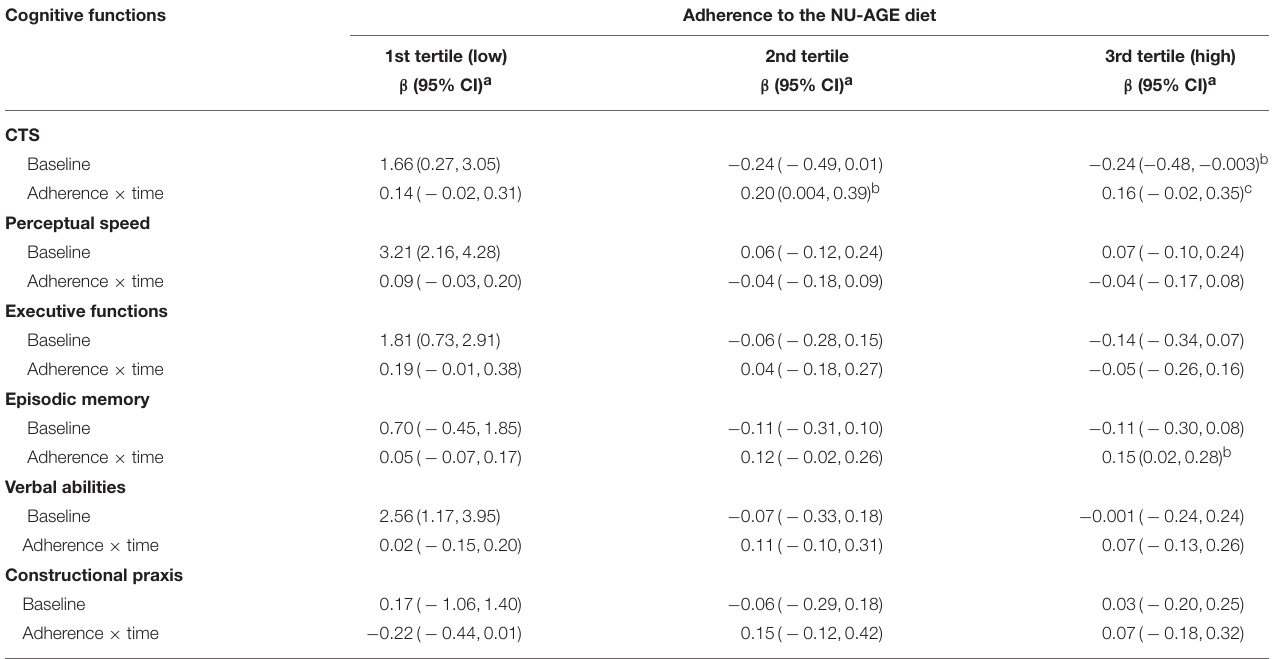
TABLE 4 | Estimated mean change in global and domain-specific cognitive functioning ( β -coefficients) and 95% confidence intervals by tertiles [1 (reference) to 3, corresponding to low to high adherence] to the NU-AGE diet over 1-year of follow-up, among the intervention group ( n = 638). Cognitive functions Adherence to the NU-AGE